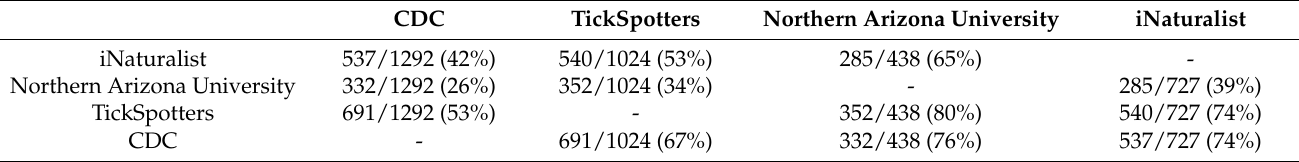
Table 4. Overlap of counties with reports of A. americanum between various US tick surveillance data sources. County-by-county comparison data are available in Table